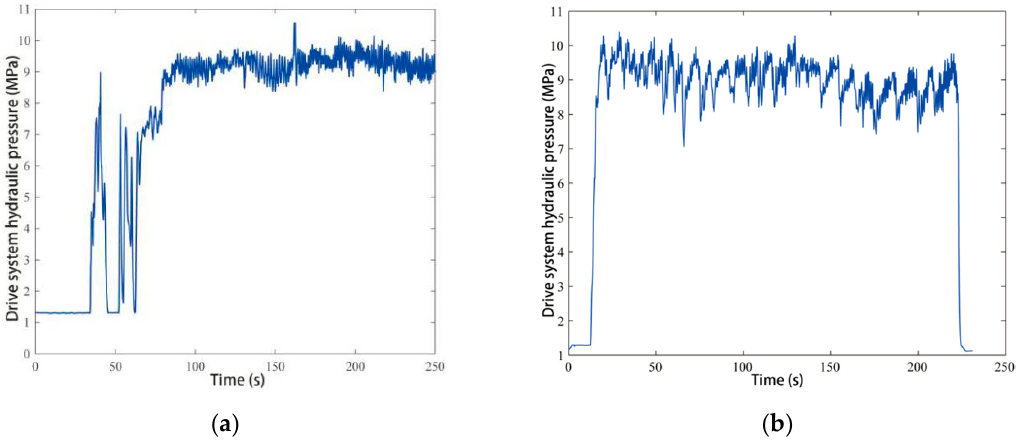
Figure 14. The drive system hydraulic pressure: ( a ) PID controller and ( b ) the proposed controller.